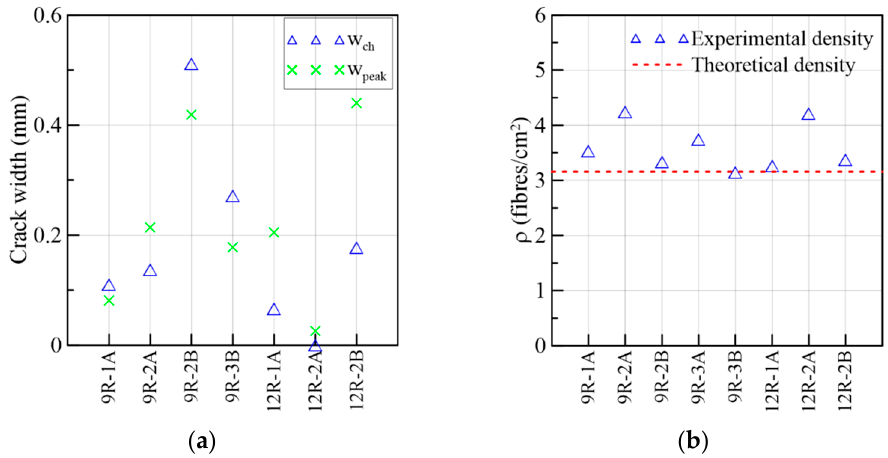
Figure 25. Mechanical results of 9R and 12R specimens: ( a ) crack widths at the change in behavior and at the peak load and ( b ) fiber densities.